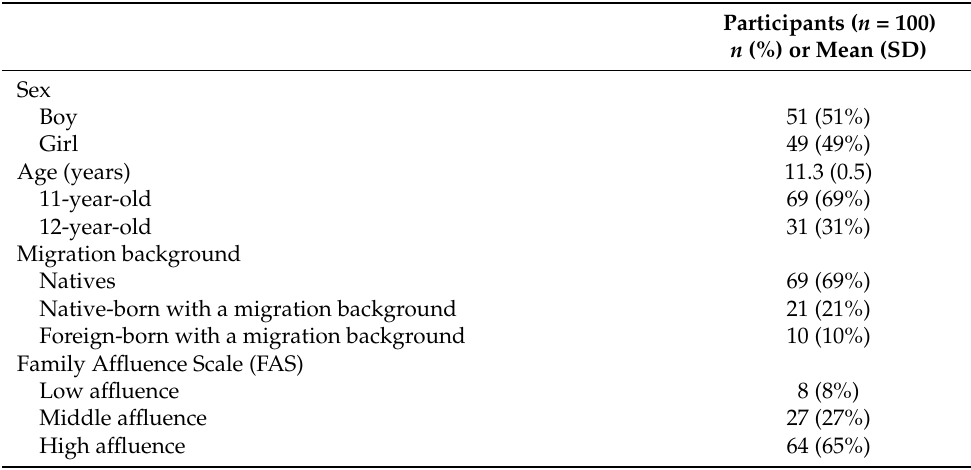
Table 2. The participants’